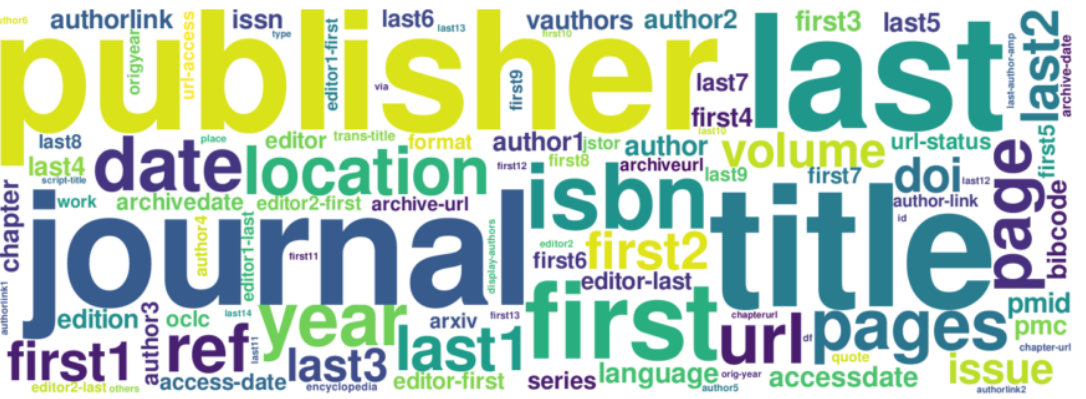
Figure 3. The most popular parameters in the Wikipedia citation templates related to scientific publications in English Wikipedia. Font size shows the frequency of use. Source: own study in November